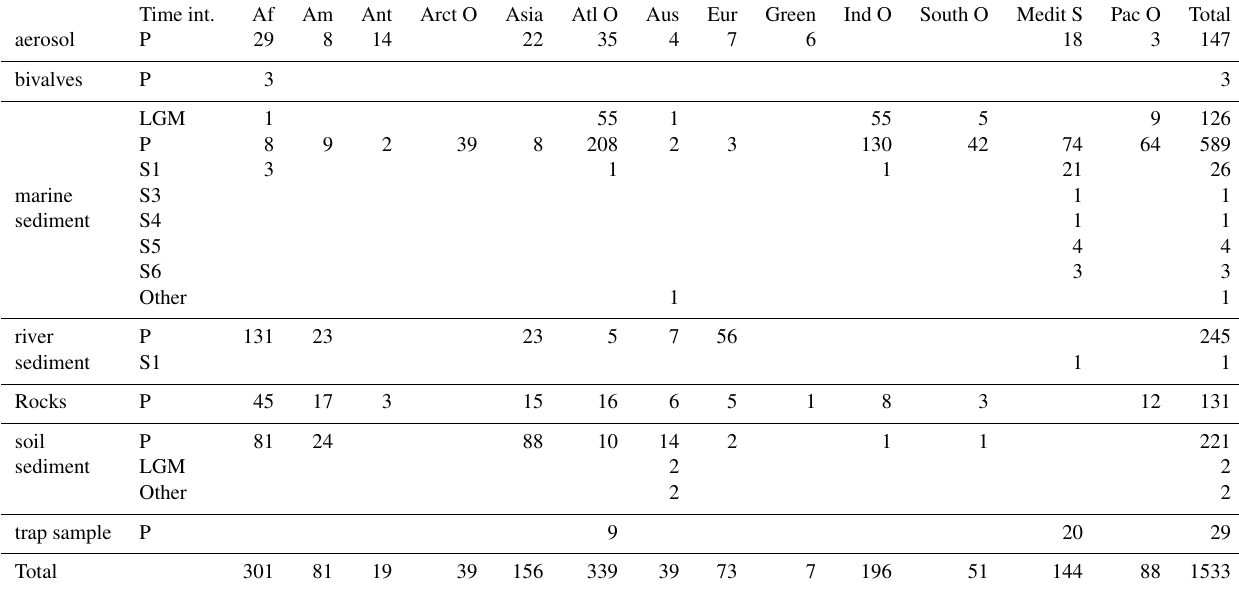
Table 4. Output table after second iteration (April 2019). Overview of the results obtained in number of data points per type of sample, time interval and location of the samples (Af: Africa, Am: America, Ant: Antarctica, Arct O: Artctic Ocean, Asia, Atl O: Atlantic Ocean, Aus: Australia, Eur: Europe, Green: Greenland, Ind O: Indian Ocean, South O: Southern Ocean, Medit S: Mediterranean Sea, Pac O: Pacific